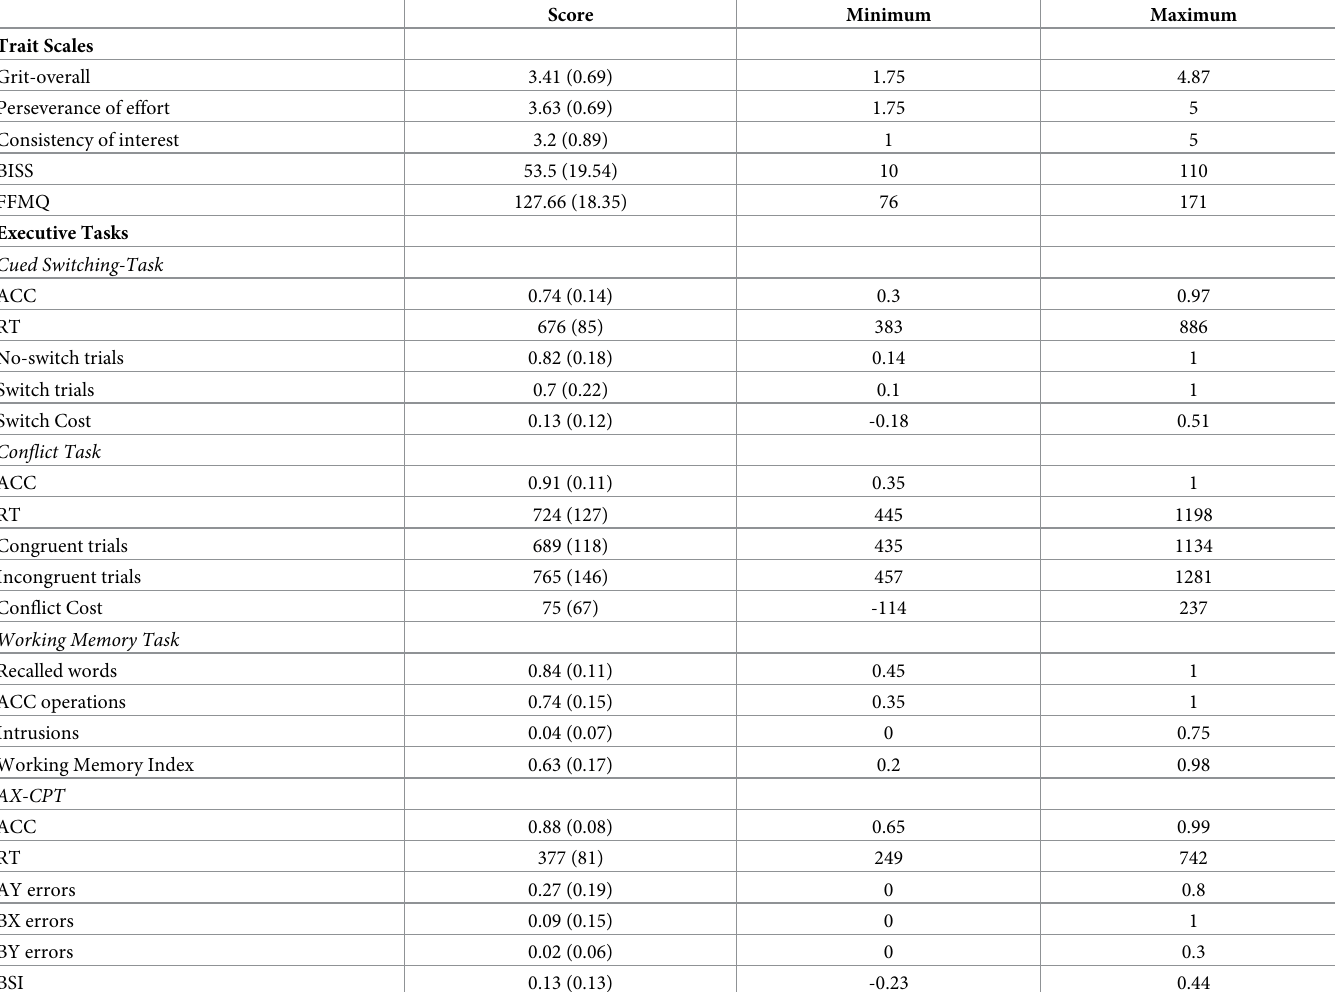
Table 1. Descriptive statistics of the scores from the personality questionnaires and experimental tasks. The first column refers to means (Ms) and standard devia- tions